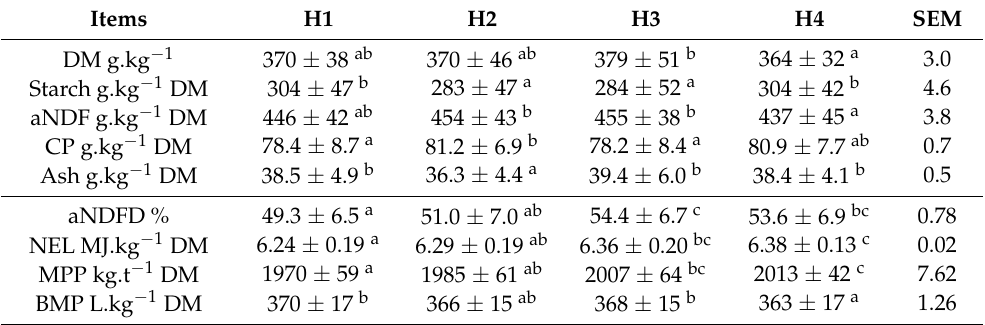
Table 7. Chemical composition and feed value of hybrids (H) irrespective of the year of